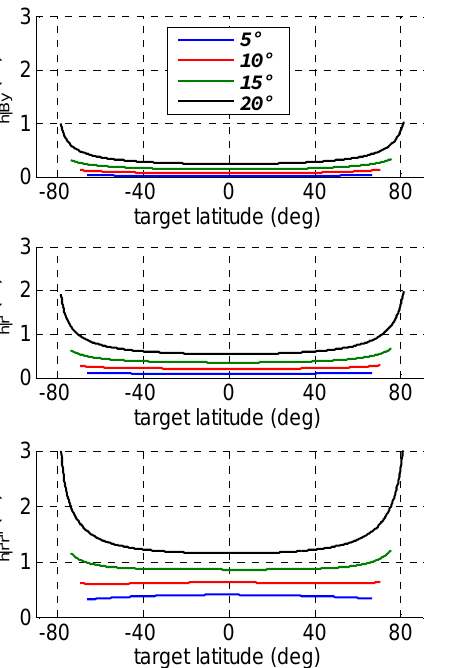
Figure 10. Contributions to height uncertainty as a function of target latitude in the bistatic rigorous SAR stereo problem for four bistatic antenna off-nadir angles (1/10 of an image pixel assumed as co-registration